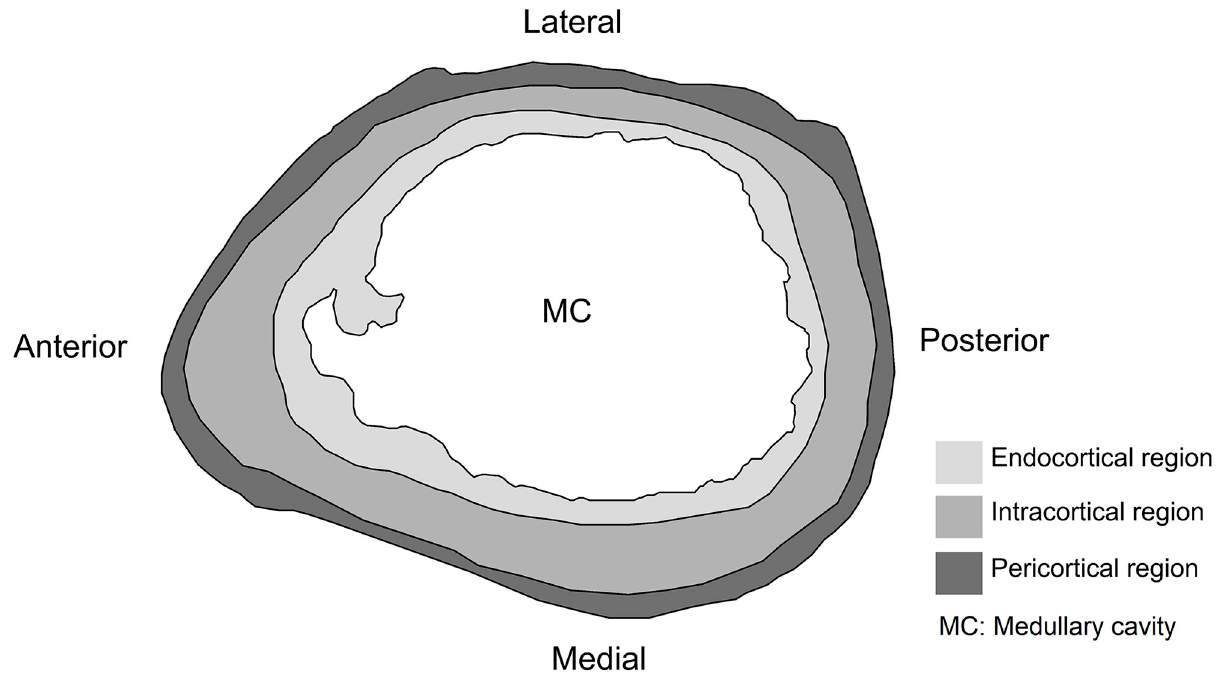
Fig 3. Right humerus cross-section diagram. Divisions of bone cortex used to describe paleohistological samples in Caraguatypotherium munozi .